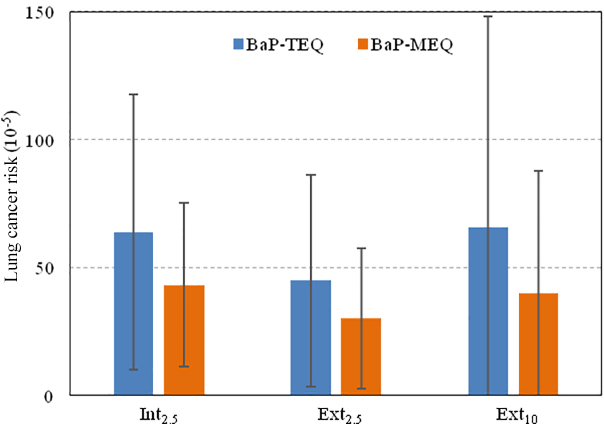
Figure 5. Lung cancer risk from the BaP-TEQ and BaP-MEQ for all three